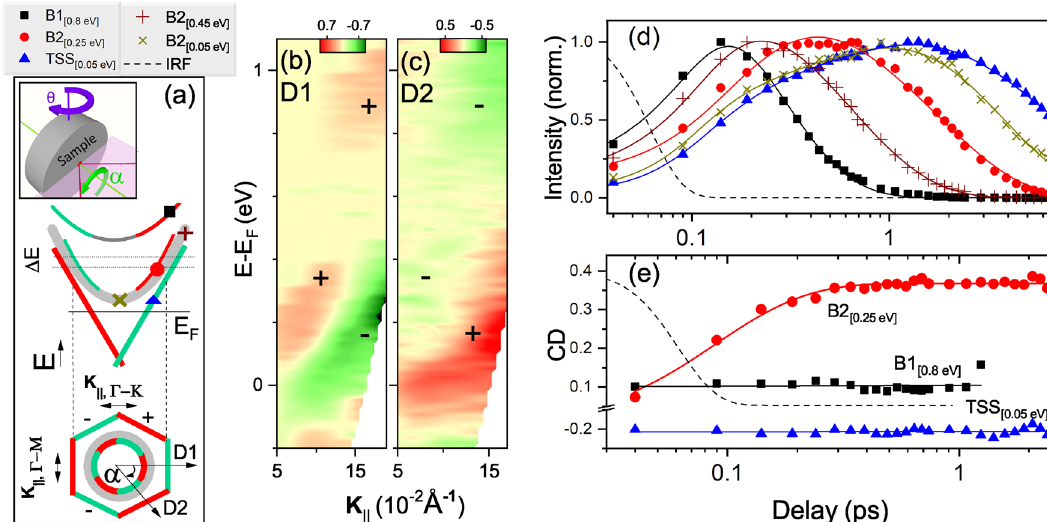
Figure 2. ( a ) Schematic representation of the out-of-plane component of spin-OAM texture 20,41 . Red (green) color indicates the outward (inward) spin direction. The colored symbols mark relevant energy-momentum points whose dynamics is shown in panels ( d )–( e ). Inset displays the rotation angles α and θ . Panels ( b ) and ( c ) show the CD-ARPES map of the sample oriented along D1 and D2 at 250 fs delay [D1 and D2 are depicted in panel ( a )]. Panel ( d ) shows the normalized electronic dynamics of the corresponding symbols in ( a ). Solid lines represent best exponential fits. IRF is the instrumental response function, corresponding to the cross-correlation of pump and probe pulses. Panel ( e ) shows the evolution of CD for B1, B2 and TSS states extracted from positions shown in ( a ). Solid lines represent linear or exponential